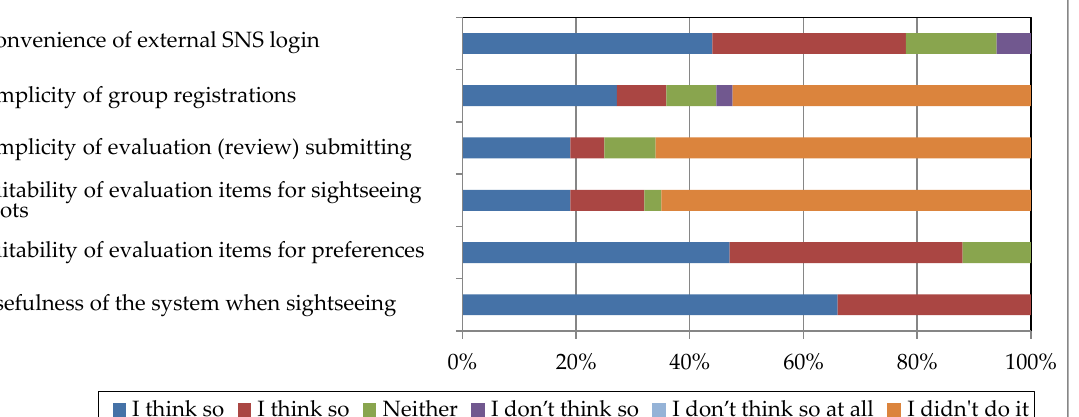
Figure 9. Evaluation of the entire system Note: “simplicity of group registration”, “simplicity of evaluation (review) submitting” and “suitability of evaluation items for sightseeing spots” include the option of “I didn’t do it.